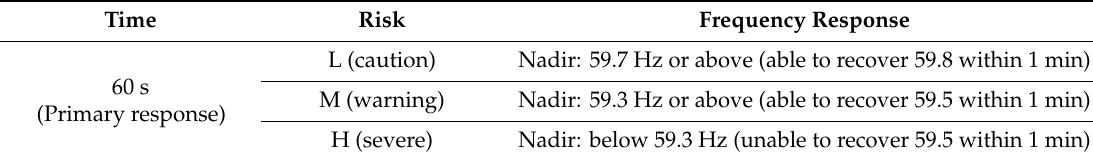
Figure 3. Frequency response during a disturbance in a power system Table 2. Risk criteria of frequency stability.